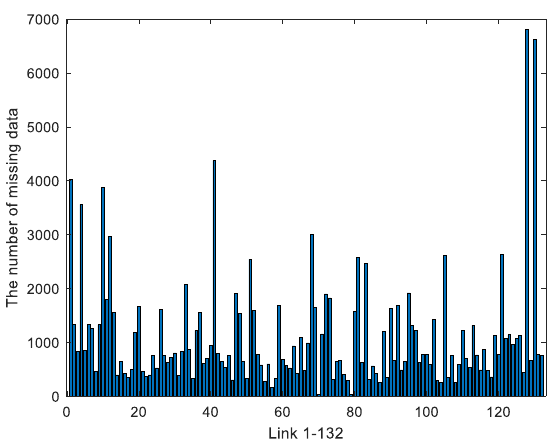
Figure 6. Missing data of each link.